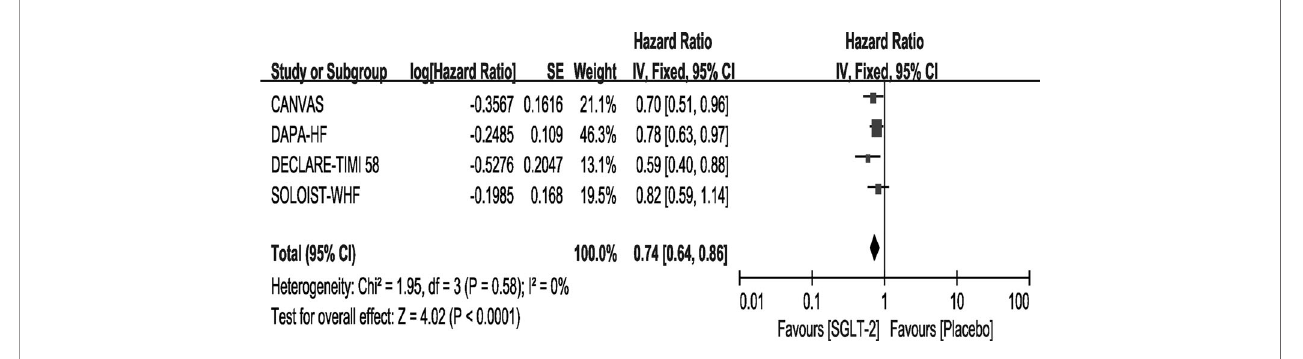
FIGURE 5 | Outcome of all-cause mortality in patients with T2DM and HF.